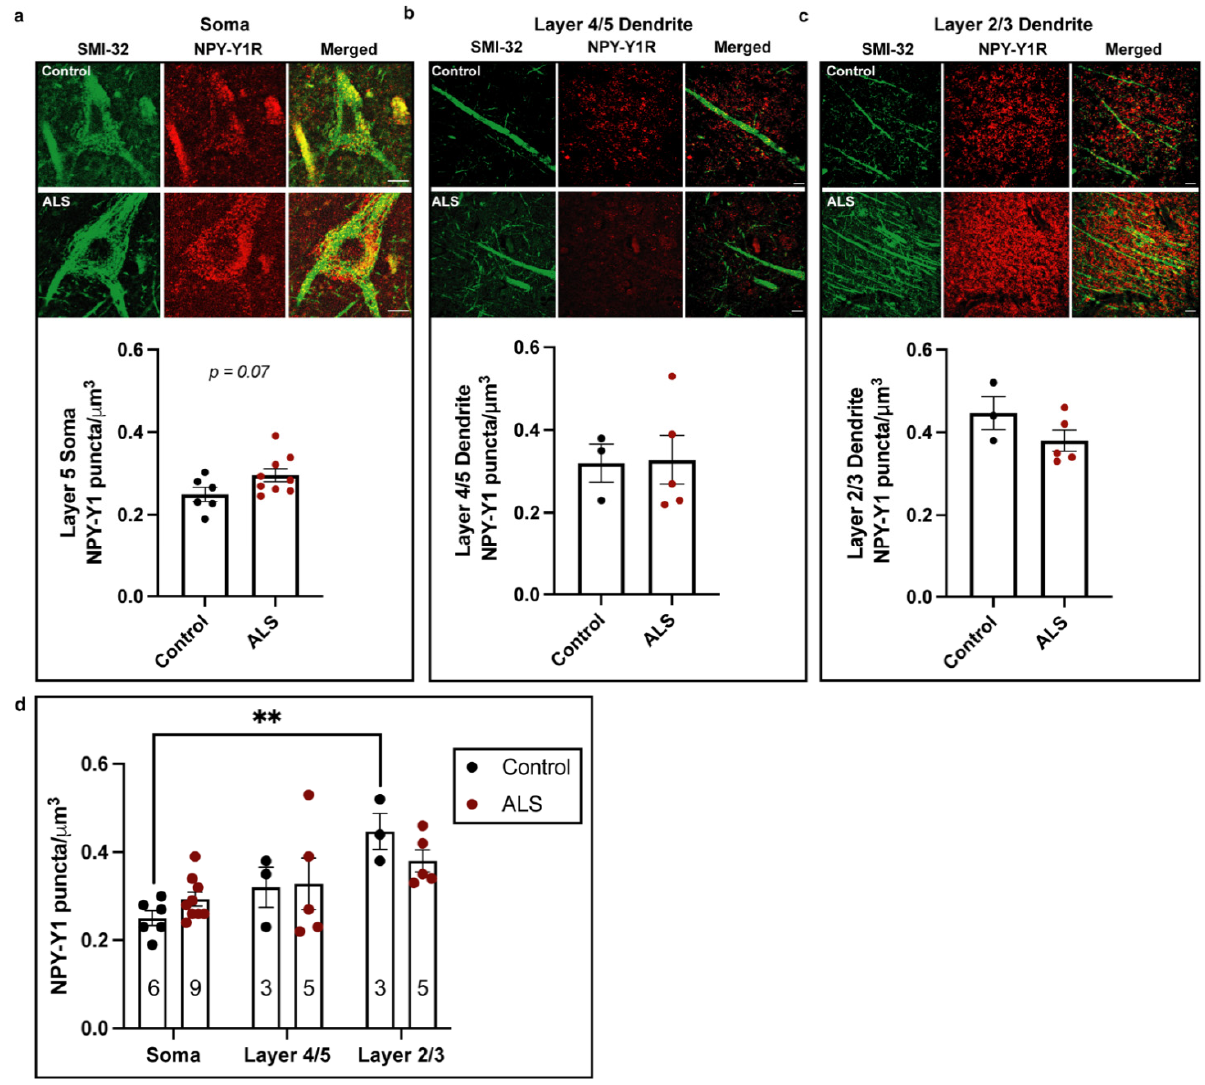
Figure 2. Immunohistochemical comparisons of NPY-Y1 receptors localized to the cell soma ( a ) and apical dendrites localized in cortical layer 4/5 ( b ) and 2/3 ( c ) of SMI32-positive upper motor neurons in the post-mortem motor cortex of ALS cases ( n = 9) and controls ( n = 6). The density of NPY-Y1 receptor puncta/µm 3 was determined using immunohistochemistry and image analysis of 3D rendered images from z-stacks using IMARIS software. ( d ) Two-way ANOVA repeated-measures comparison of NPY-Y1 receptor density between cortical layers on upper motor neurons from controls and ALS case motor cortex. Values in bars represent the average values of individual cases and controls. Bars represent the group mean ± SEM. ** p < 0.01. Scale bar = 10 µm.